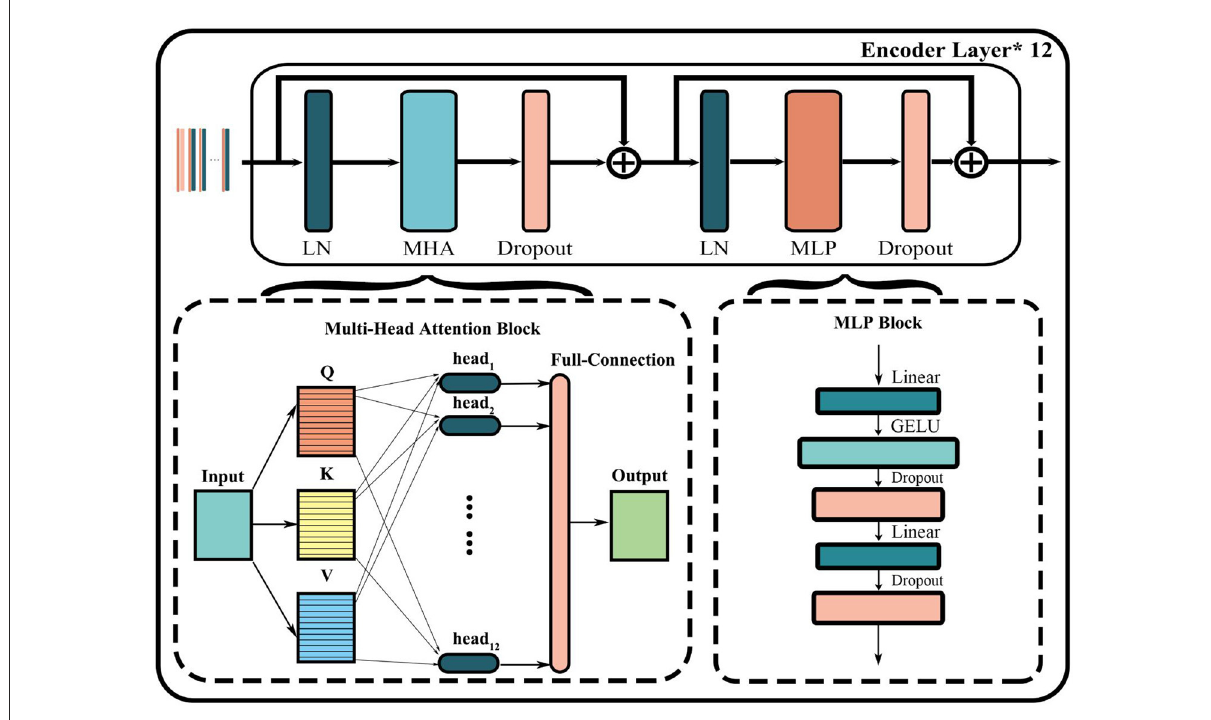
FIGURE3 Structure of encoder layer in Vision Transformer.